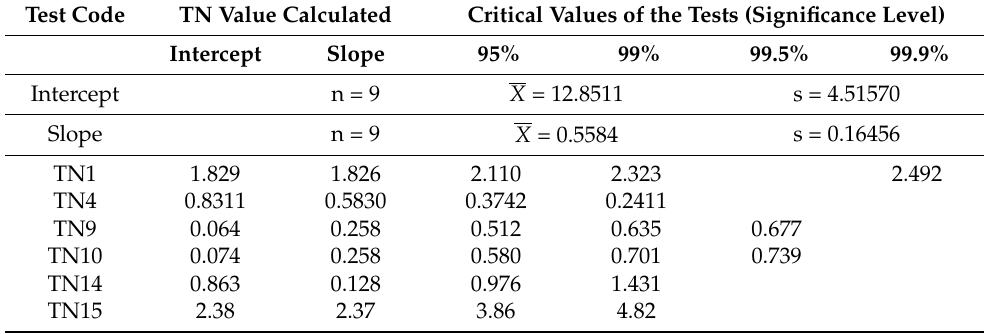
Table 5. Results of the discordance tests of the equations for a hot-dry climate.